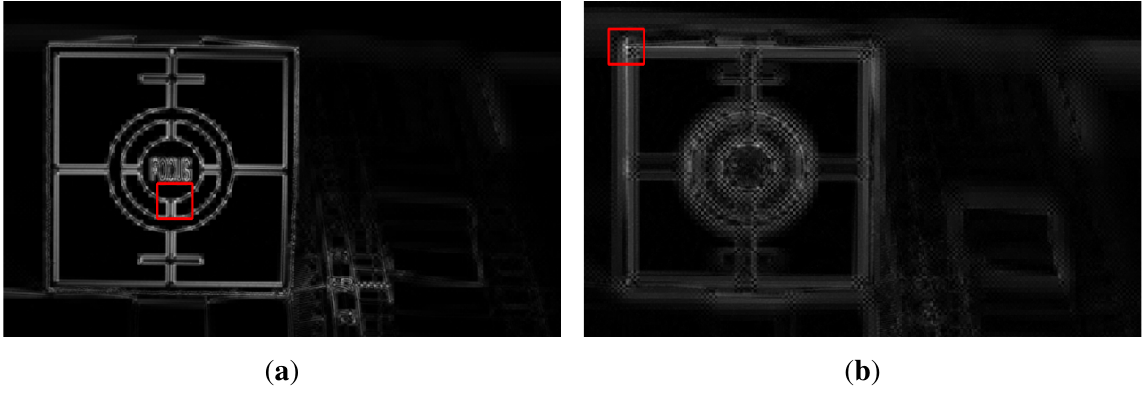
Figure 10. Results of feature extraction in the cropped region of Figure 9: ( a ) the feature of the in-focus image shown in Figure 9b,c and ( b ) that of the front-focus image shown in Figure